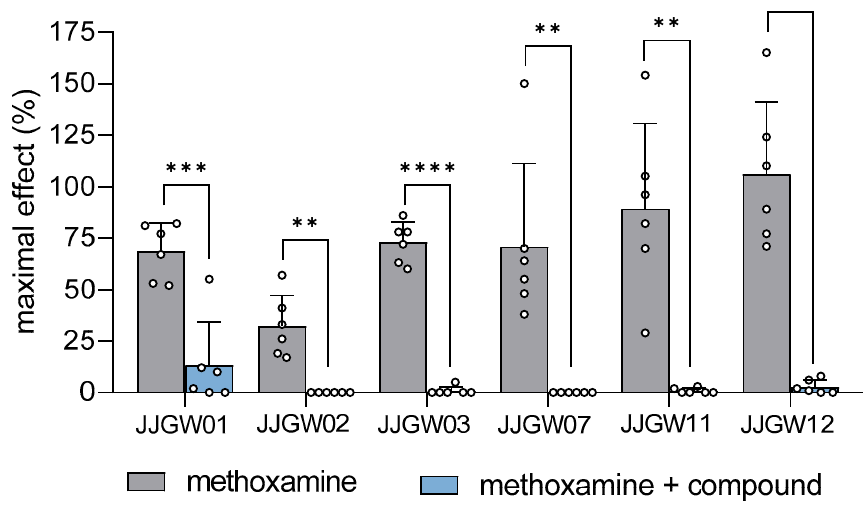
Figure 2. The effect of arylpiperazine derivatives on the blood pressure response to methoxamine in rats. Pressor response to methoxamine (150 µ g/kg) was estimated before and 5 min after the intravenous ( iv ) administration of the studied compounds at the lowest hypotensive doses (JJGW01 1mg/kg, JJGW02 2.5 mg/kg, JJGW03 5 mg/kg, JJGW07 5 mg/kg, JJGW11 2.5 mg/kg, JJGW12 5 mg/kg). The results are presented as means ± SD. Statistical analysis: paired t -test; ** p < 0.01, *** p < 0.001, **** p < 0.0001; n = 6 rats .